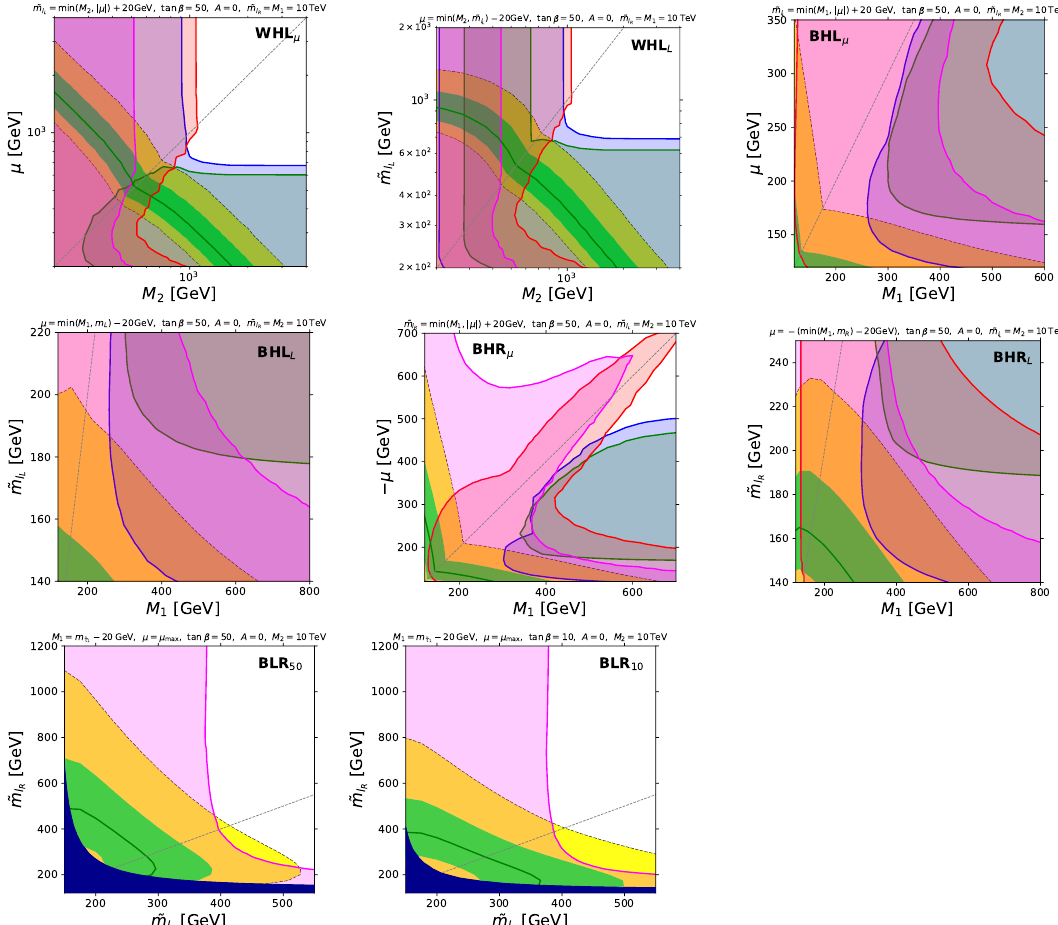
Figure 9 . All considered planes for GMSB scenario with neutralino NLSP. Region of parameter space allowed by the latest a experimental results [4] is depicted with green and yellow bands, µ corresponding to one and two sigma agreement respectively. Blue, green, red and magenta shaded regions are excluded by LHC constraints. Dark blue shaded area is excluded by LEP stau mass bound